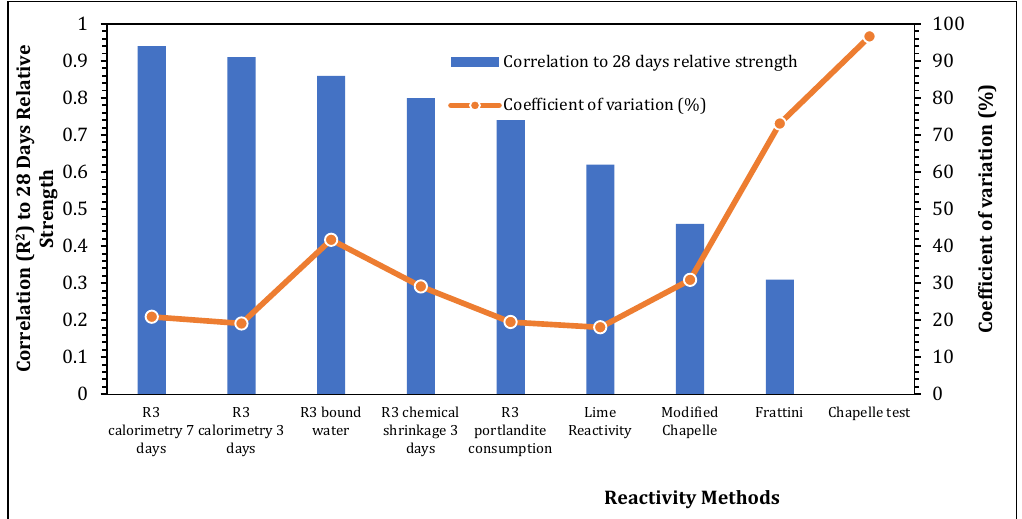
Figure 8. Summary of different reactivity methods [217].